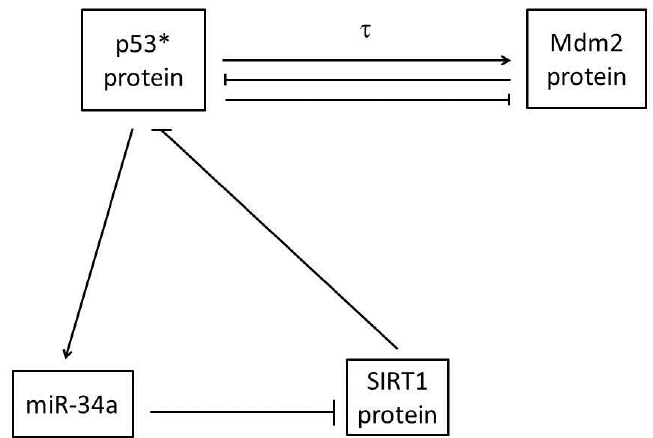
Figure 2. A simplified relationship containing the main components of the p53 signal network. The central node p53* connects two feedback loops. One is a negative feedback loop formed by p53* and Mdm2 with time delay, and the other is a positive feedback loop formed by p53* and miR-34a with the feature of double-negative regulation.